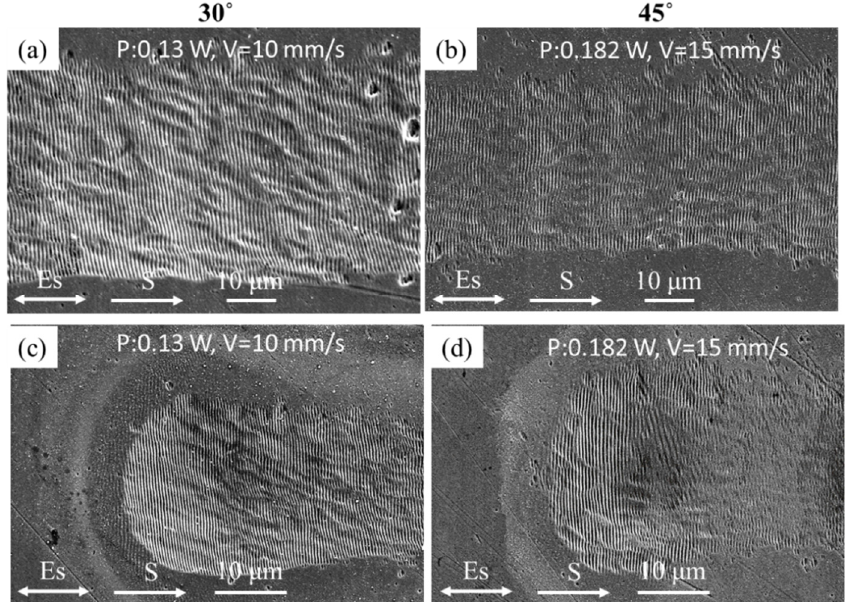
Figure 4. SEM images of the LSFL generated by the line scanning process for the Cu irradiated by 515 nm laser with ( a , c ) θ = 30° and ( b , d ) 45°; ( c , d ) scanning start regions.